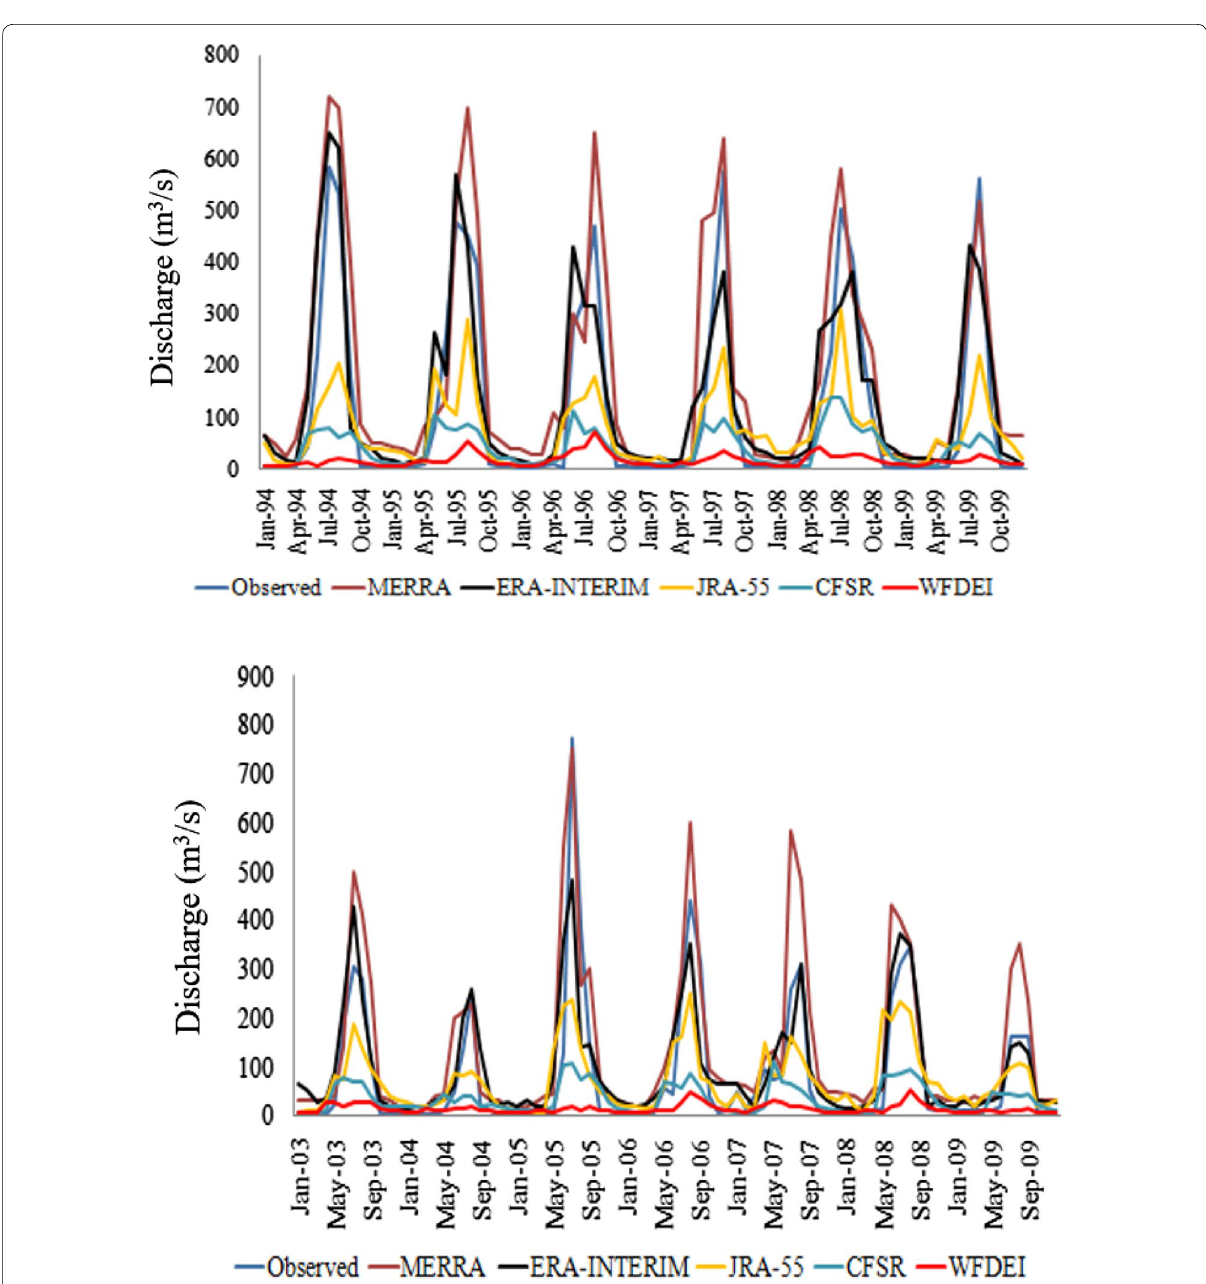
Fig.20 Hydrograph of observed and simulated flow of Pandoh dam for calibration period (1994–1999) and validation period